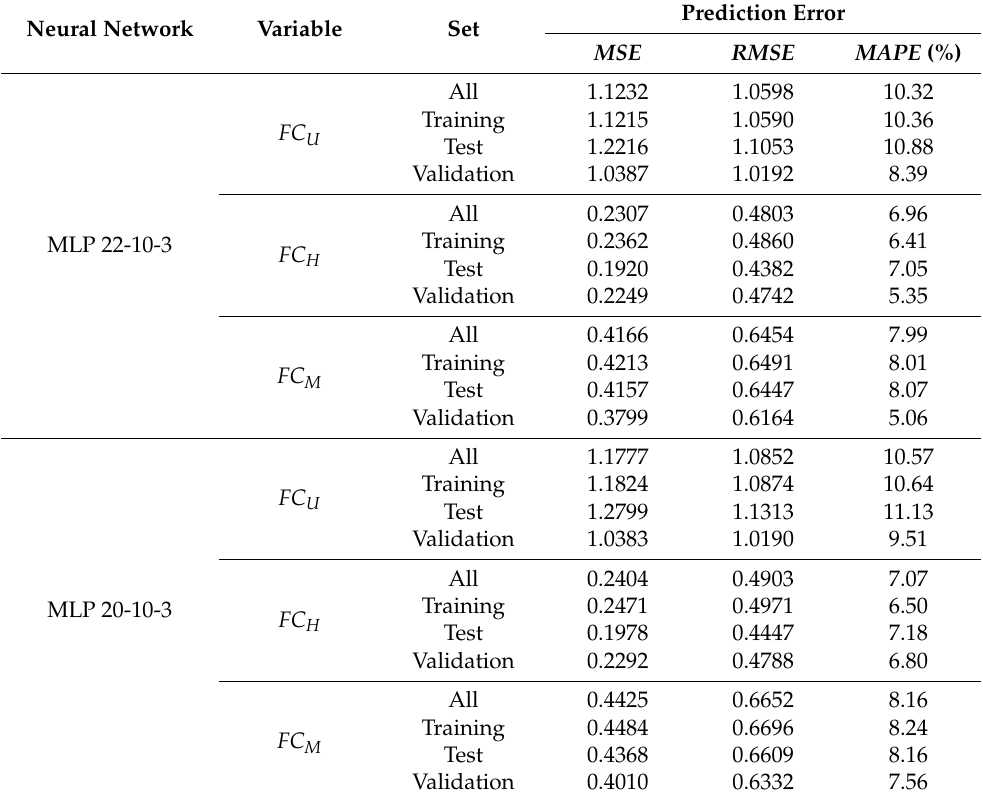
Table 11. Prediction errors of the